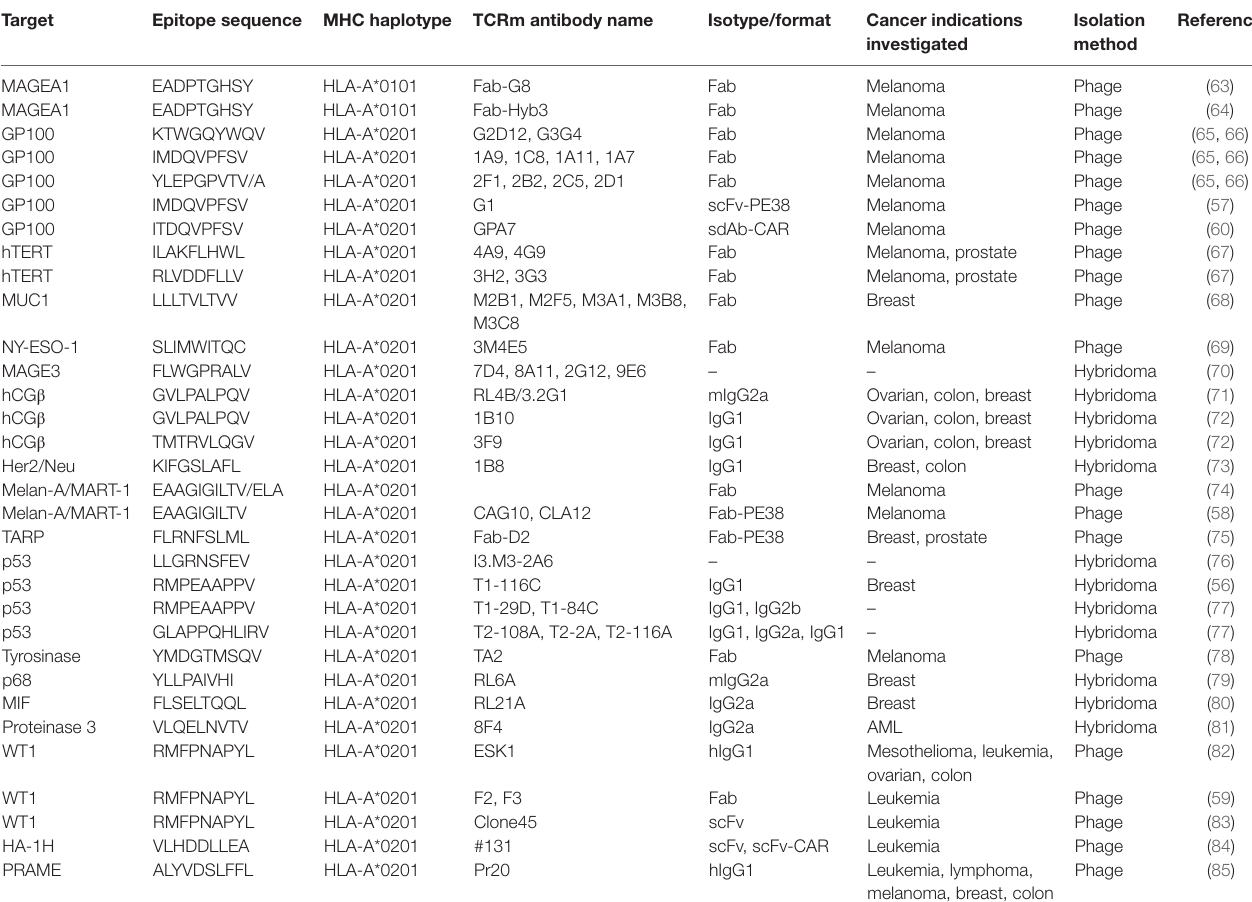
TABLe 1 | TCRm antibodies for cancer